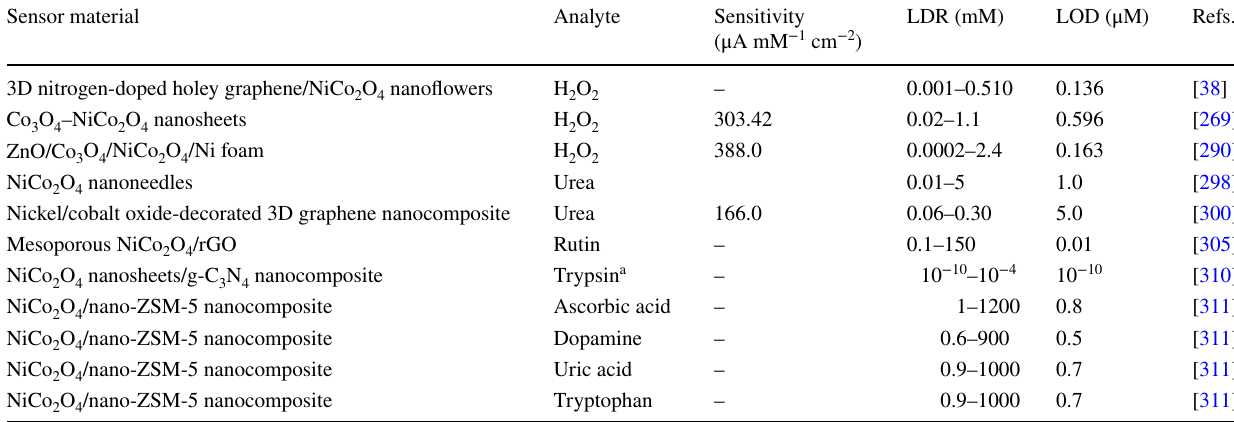
Table 2 Electrochemical sensing parameters for various NiCo 2 O 4 -based modified electrodes toward some bioanalytes Sensor material Analyte